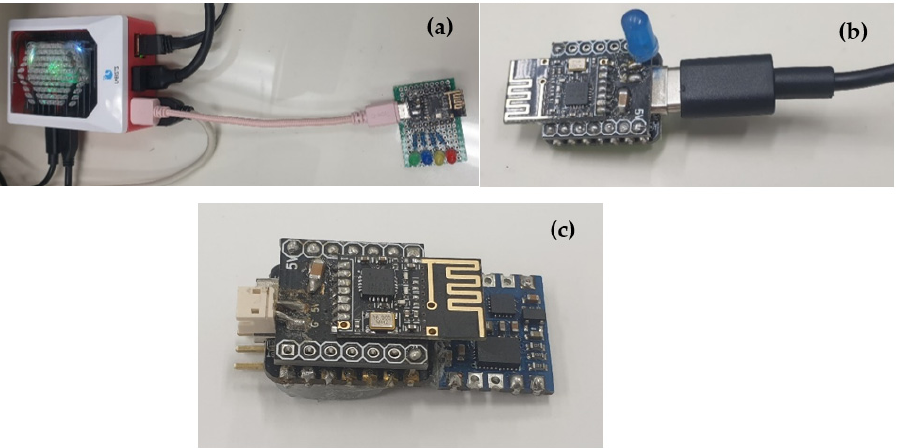
Figure 2. Developed electronic backpack and wireless transceiver, ( a ) utilized Raspberry Pi and the wireless transmitter, ( b ) wireless transceiver, ( c ) electronic